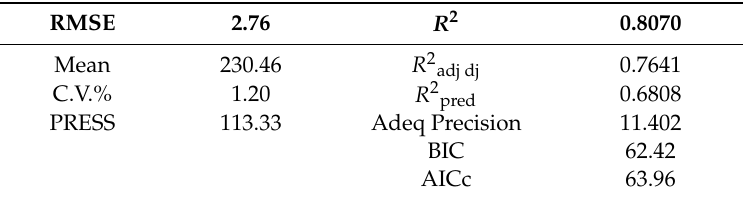
Table 4. Analysis of statistical